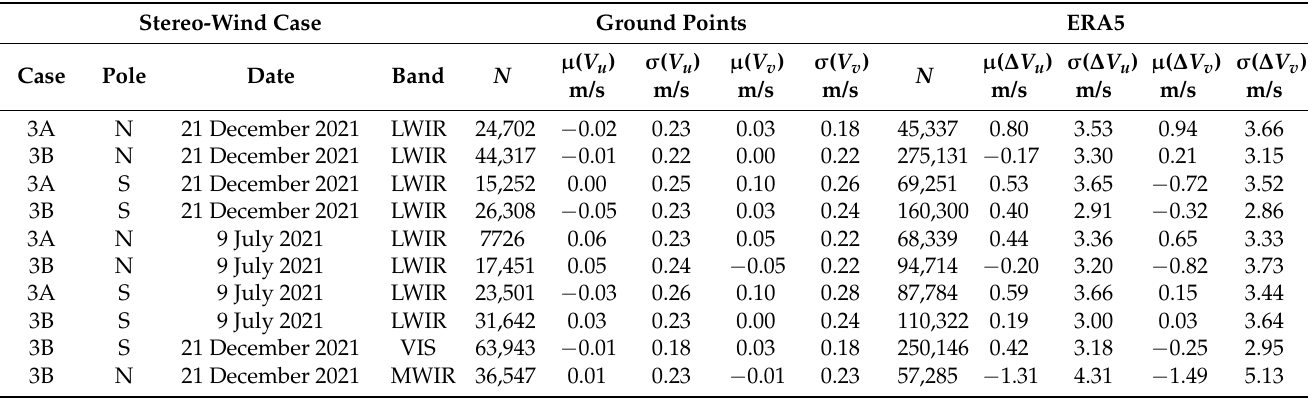
Table 3. Ground-point statistics and ERA5 reanalysis comparisons. Velocity ( V ) components are resolved along ( u , v ) coordinate axes. The means µ and standard deviations σ of each population N are reported for the indicated